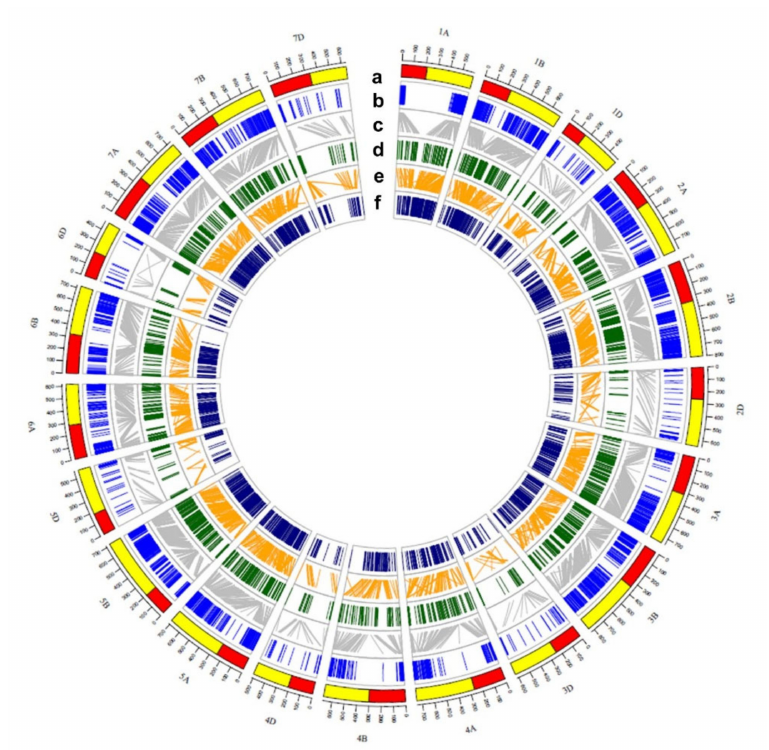
Figure 4. The circos graph of the consensus map of BW–SpB, the consensus map of Wang et al. (2014), and the physical map of the wheat genome (IWGSC RefSeq v1.0). ( a ) The chromosomes and the physical location scale of wheat. ( b ) Physical map of the SNP markers using in BW–SpB. ( c ) The collinearity between the consensus map of BW–SpB and the physical map. ( d ) The consensus map of BW–SpB. ( e ) The collinearity between BW–SpB and the consensus map of Wang et al. ( f ) The consensus map of Wang et al.